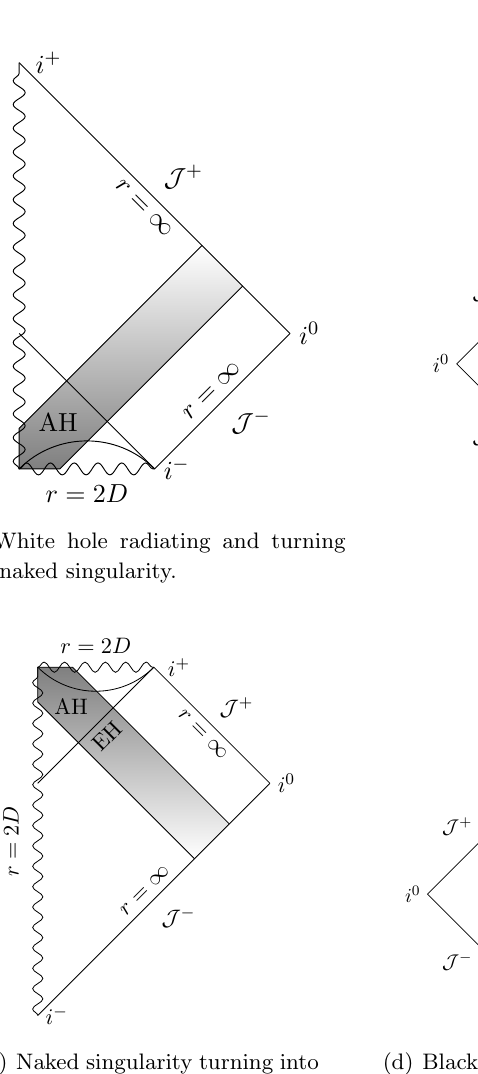
(c) Naked singularity turning into (d) Black hole accreting null dust with negative energy a black hole by accreting null dust. density and turning into a naked singularity. Figure 5 . Some examples of Carter-Penrose diagrams corresponding to dynamical spacetimes sourced by null dust described in the main text. The event horizon and the apparent horizon are indicated by EH and AH, respectively, while pEH denotes a past event